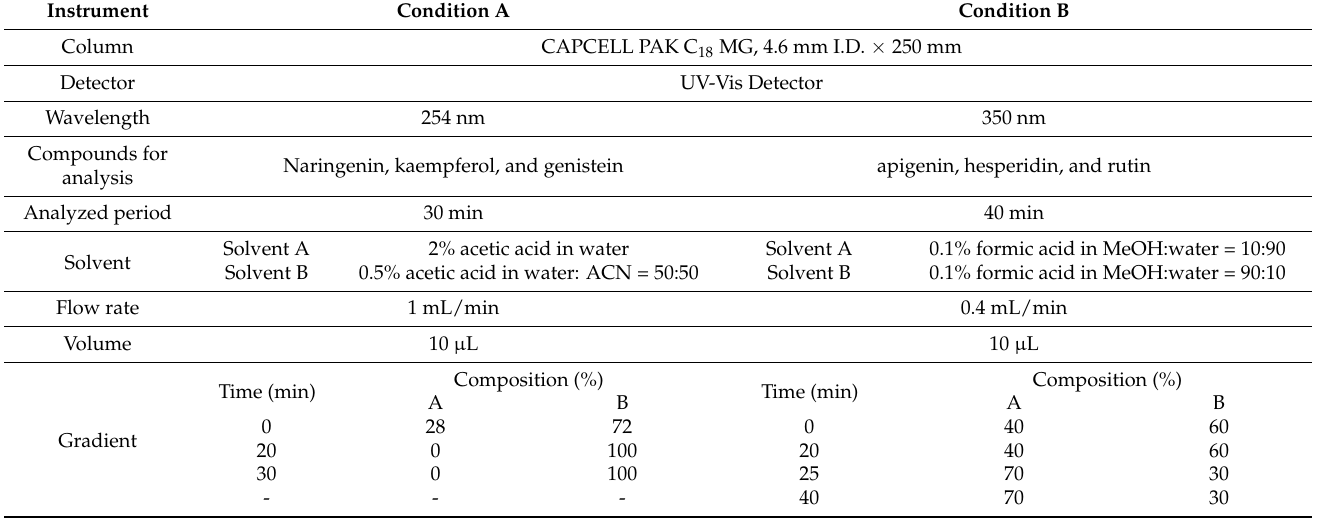
Table 2. Instrument and working conditions for